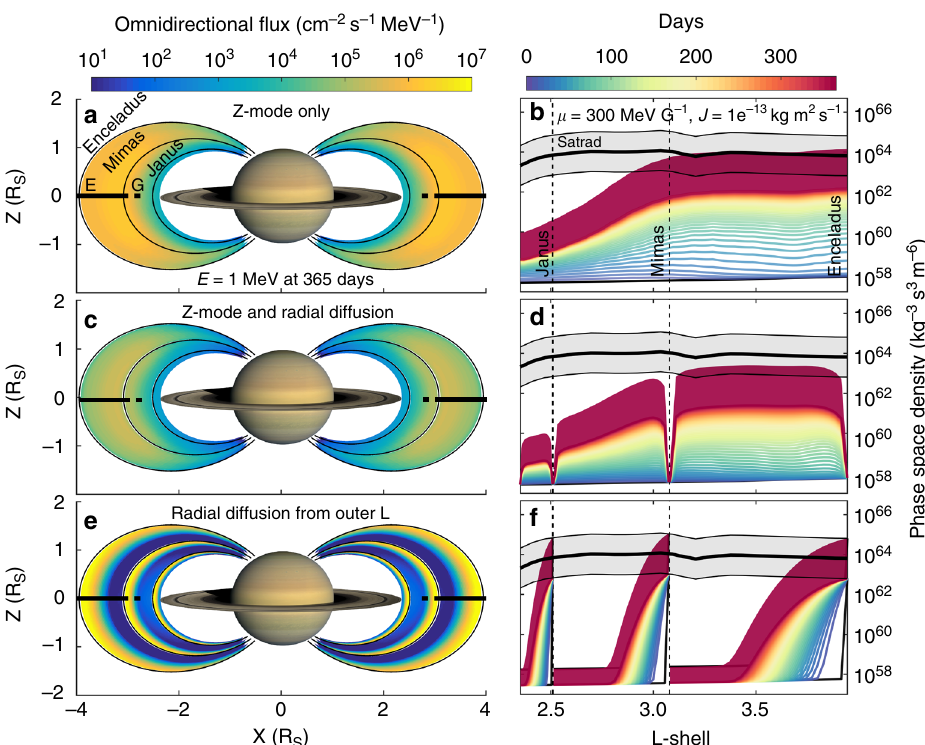
Fig. 5 Comparison of the effects of Z-mode waves and radial diffusion inside 4 R S . a , c , e Differential fl ux at 1 MeV after 365 days summed over all pitch angles where the labels E and G refer to the E and G rings. b , d , f Phase space density at constant fi rst and second adiabatic invariants ( µ , J ) corresponding to 1 MeV and 50° pitch angle at L = 3. SATRAD model and uncertainty range shown in gray, evolution over equal time steps of 7 days starting in black lines through blue and yellow, fi nishing in red. The broad red band shows the range of possible fi nishing points for the phase space density after 365 days given uncertainties in the SATRAD model. a , b Purely local wave acceleration at each L-shell with no radial diffusion. c , d Local and radial diffusion run together showing the smoothing out of the locally accelerated electrons. e , f Radial diffusion only using the same initial condition as a – d but with an added SATRAD energy spectrum just inside the orbit of each moon to form the radial seed population. A worst case absorption has been assumed for the moons, where all electrons are absorbed, in reality the effects of the moons will be